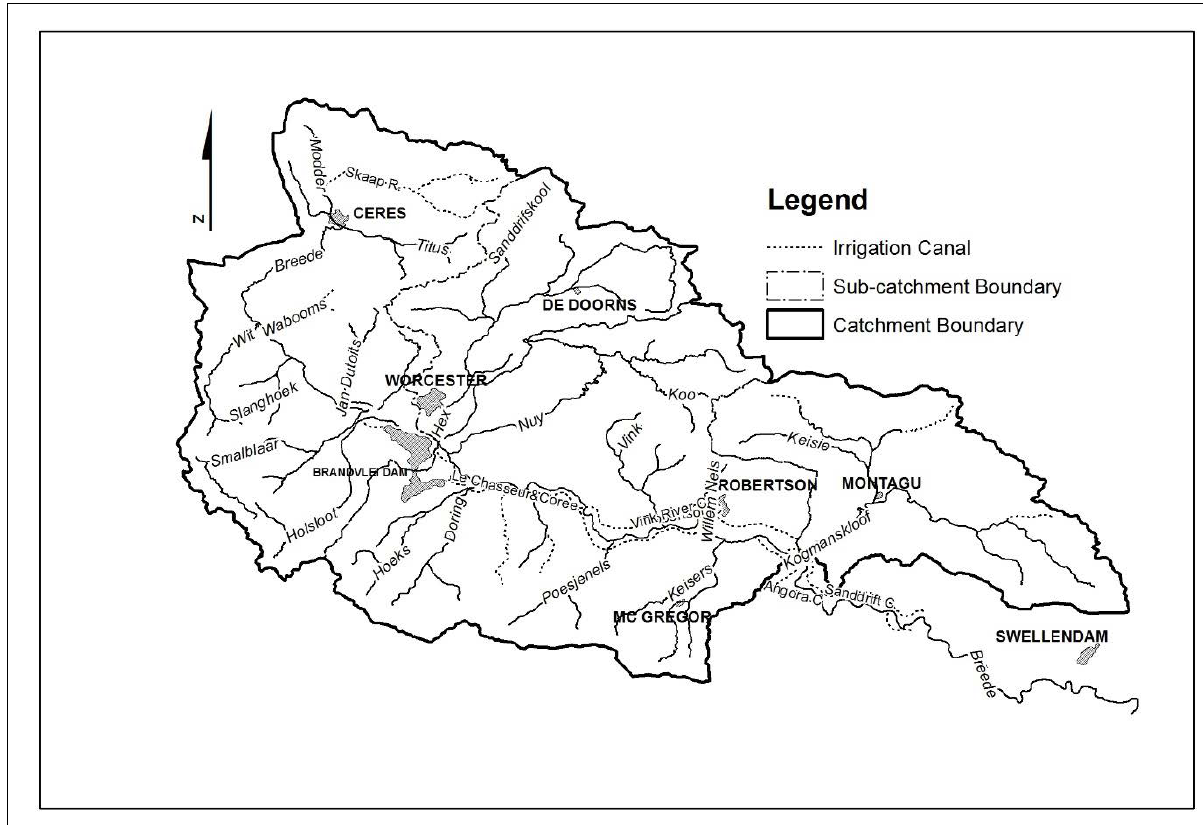
Figure adapted from Kienzle and Flügel 62 . figure 3: Map showing the irrigation canal system of the Upper and Middle Breede